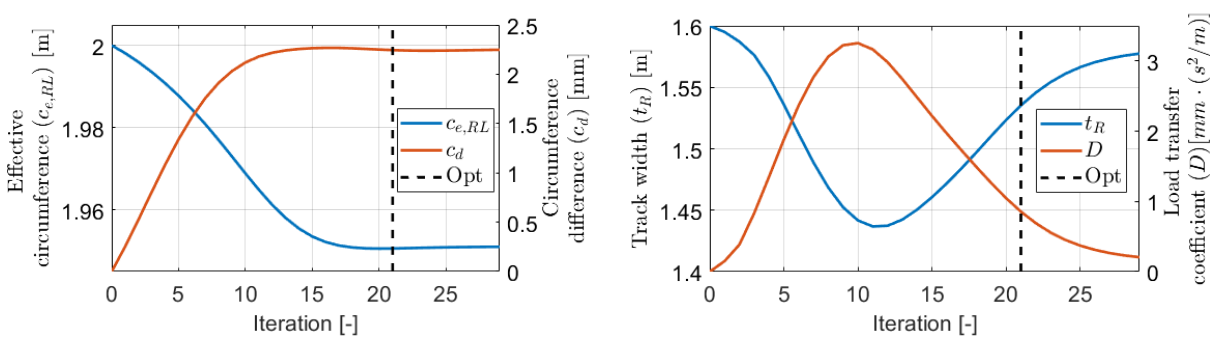
Figure 20. Estimated parameters in the